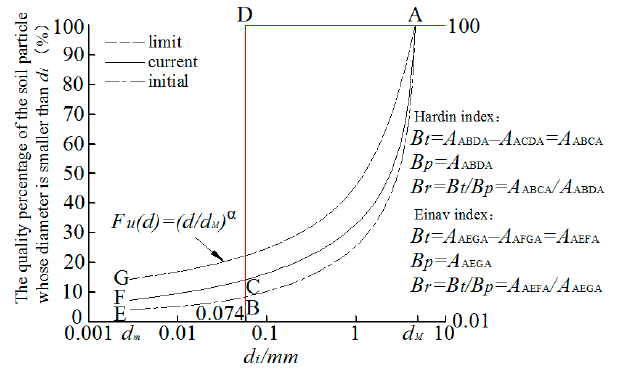
Figure 2. Definition of relative breakage.